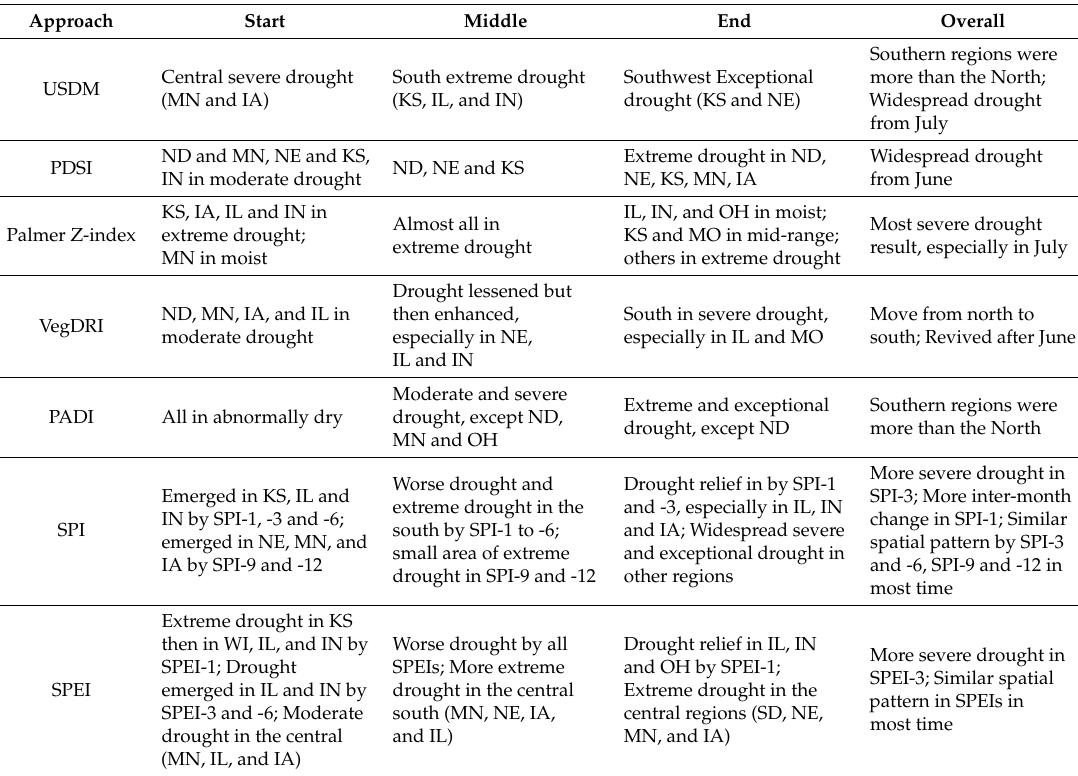
Table 3. Comparison between Different Drought Assessment Methods in Describing Drought Spatial-Temporal Distribution and Evolution.